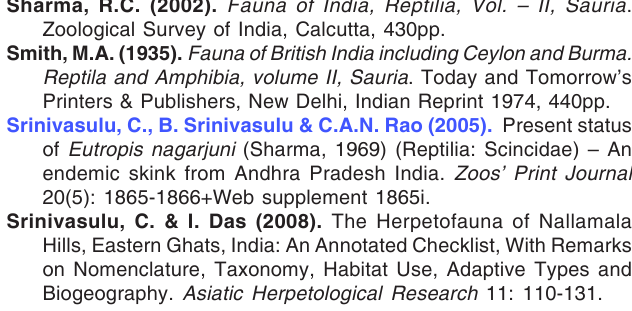
on Nomenclature, Taxonomy, Habitat Use, Adaptive Types and Biogeography. Asiatic Herpetological Research 11: 110-131.